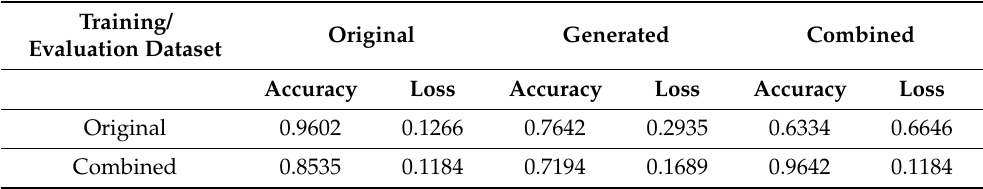
Table 7. Accuracy and loss results for different trained model of the NN classifier and three different evaluation